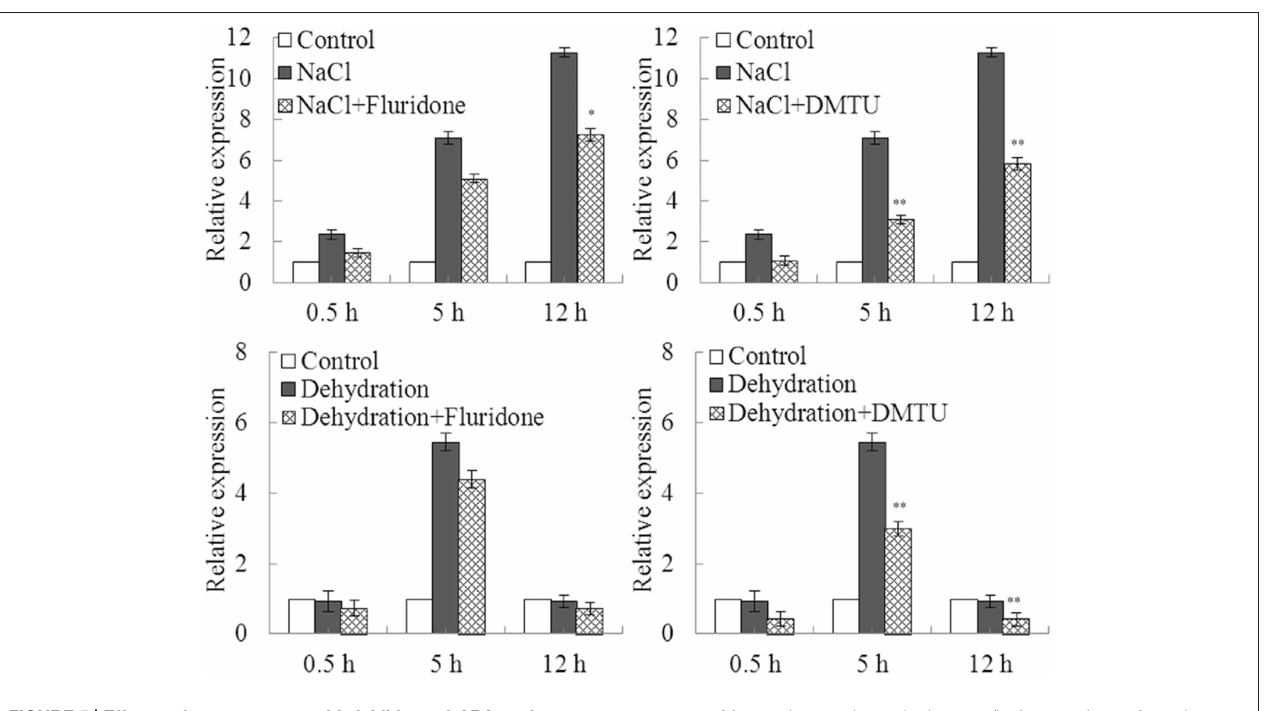
stresses. Mean values and standard errors (bar) were shown from three independent experiments. * and ** indicated significant expression differences in comparison with expression without inhibitor pretreatment at 0 . 01 < P < 0 . 05 and P < 0 . 01 , respectively ( t